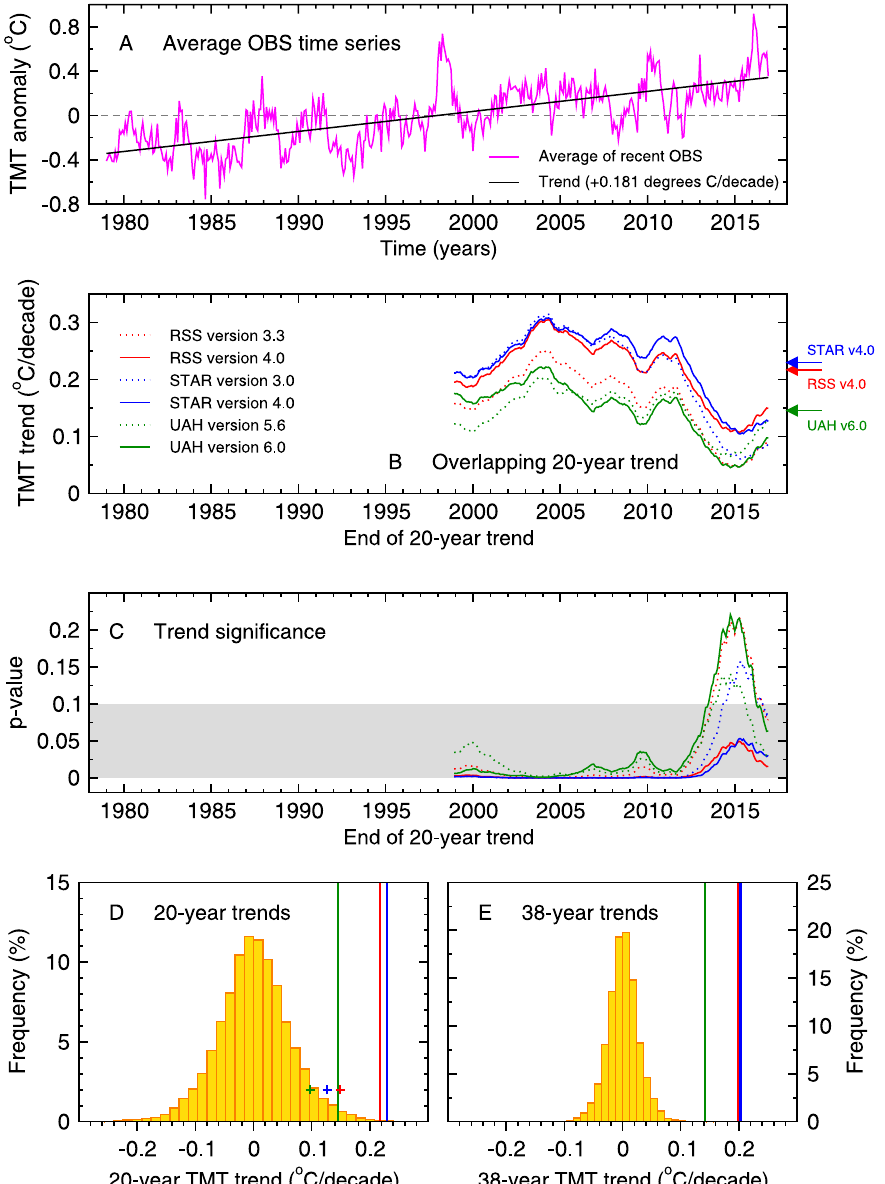
Figure 1. Evaluation of claimed “leveling off” of warming in satellite temperature data. Results are for monthly- mean anomalies in the temperature of the mid- to upper troposphere (TMT), corrected for stratospheric cooling 8 and spatially averaged over 82.5°N–82.5°S. The average of the latest satellite dataset versions (RSS v4.0, STAR v4.0, and UAH v6.0) has a warming trend of 0.181 °C/decade over the 456-month period from January 1979 to December 2016 (panel A). Maximally overlapping 20-year (240-month) trends in the six individual satellite TMT time series are plotted on the end month of the trend-fitting period (panel B). The p -values for these trends (panel C) are for tests of the null hypothesis that observed tropospheric warming could be due to natural internal variability alone 3 . The grey shaded box is the rejection region (at a stipulated 10% significance level) for the null hypothesis. The p -value calculations rely on estimates of the multi-decadal internal variability of the climate system from model pre-industrial control runs. These simulations have no year-to-year changes in natural or human external forcings. The sampling distributions of control run TMT trends on 20-year and 38-year timescales (the orange histograms in panels D and E, respectively) are based on results from 36 different models. The symbols (plus signs) in panel D are the final 20-year trends from panel B. Bold vertical lines in panel D are the averages of the overlapping 20-year trends in panel B (see arrows to the right of panel B). Vertical lines in panel E are observed trends over the full 456-month satellite record. Results in D and E are for the latest satellite dataset versions only. Full analysis details are in ref. 3 and the Methods